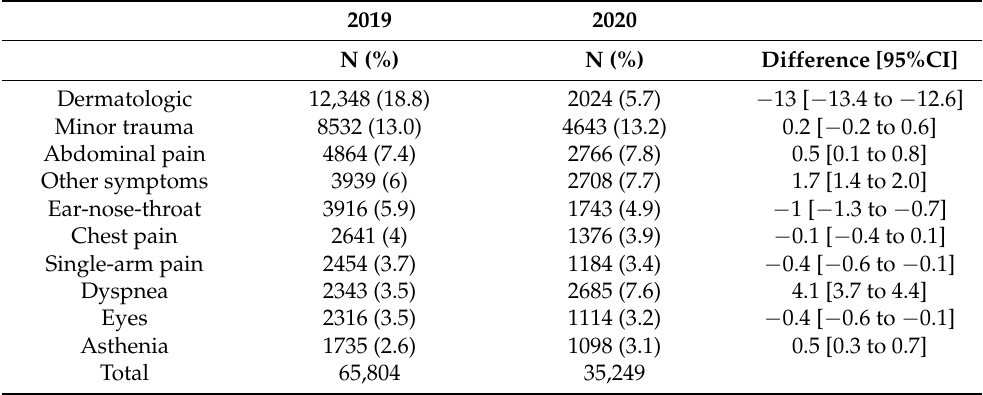
Table 1. Top-10 reasons for ED presentations in 2019 compared to